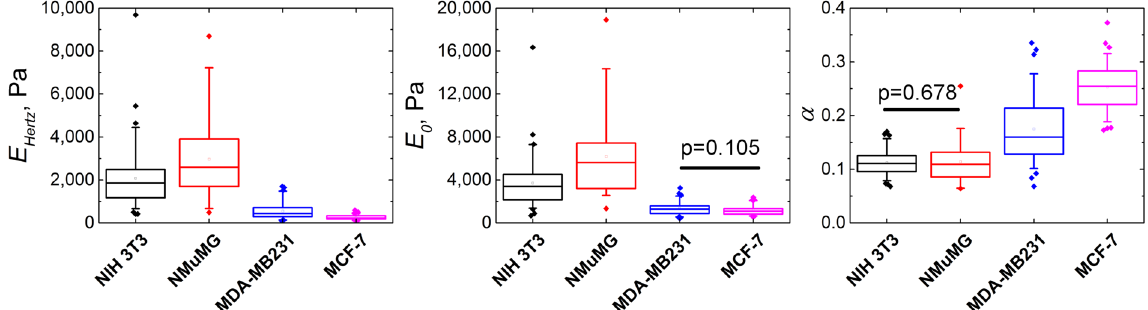
Figure 5. Viscoelastic parameters of studied cell lines. Box plots of apparent Young’s modulus E Hertz , short-term modulus E 0 and power-law exponent α . Difference between all distribution except those marked is significant at the p < 0.01 level. All cell lines were at 60–80% confluence during the experiment.